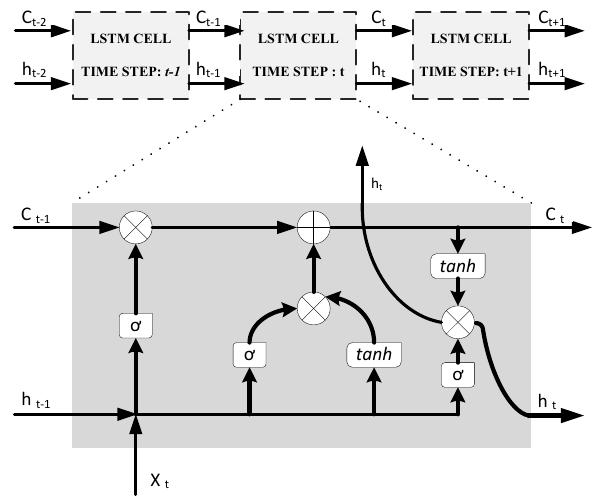
Figure 5. LSTM-RNN cell